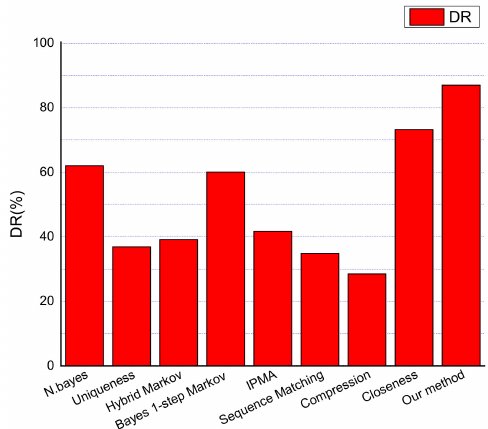
Figure 11. The DR comparation of di ff erent algorithms on UNM_live_lp.